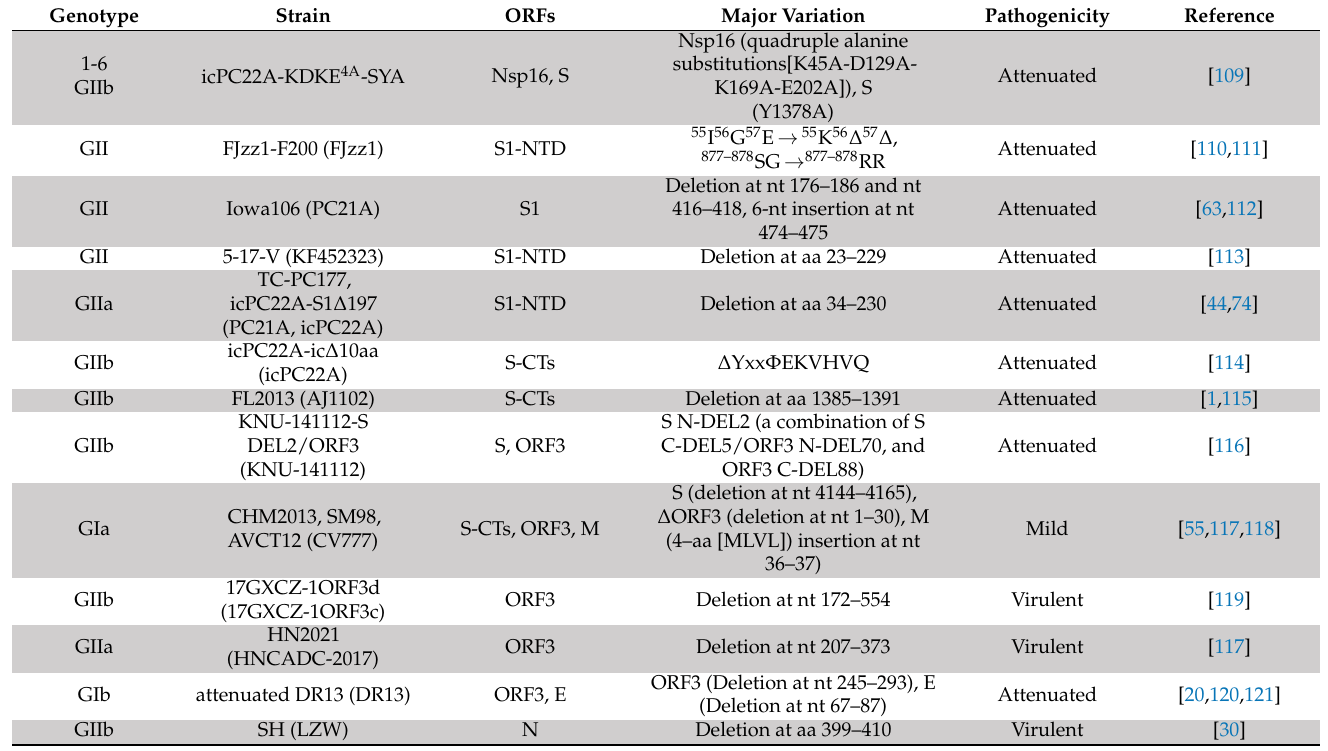
Table 2. Representative PEDV strains with protein variations that influence changes in viral